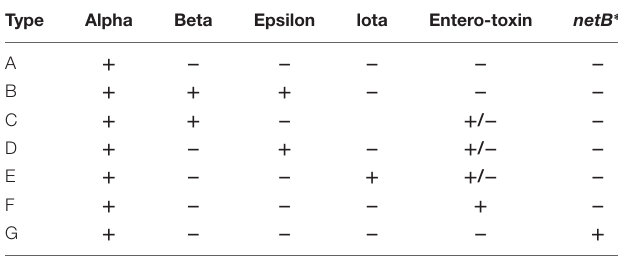
TABLE 1 | Toxin type classification system for C.